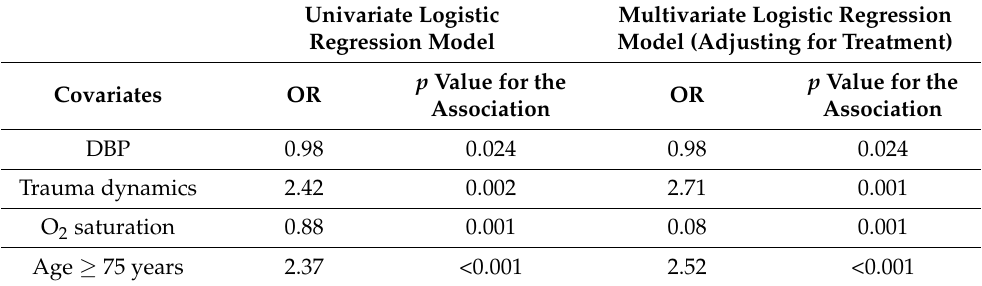
Table 4. Logistic regression models for the association between covariates and bleeding outcome.